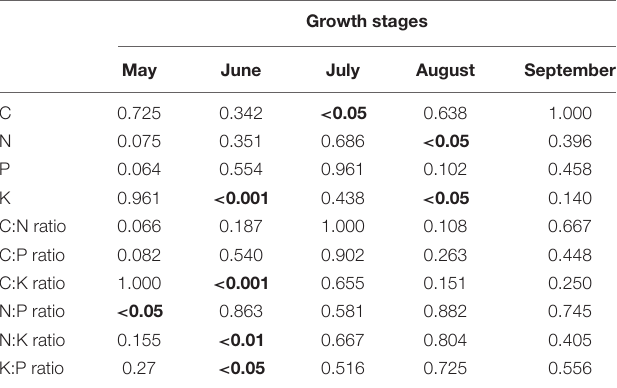
TABLE 1 | Results ( p -values) of permutational ANOVAs on the effects of wetland restoration and degradation on ecological stoichiometry of Carex schmidtii during the growth